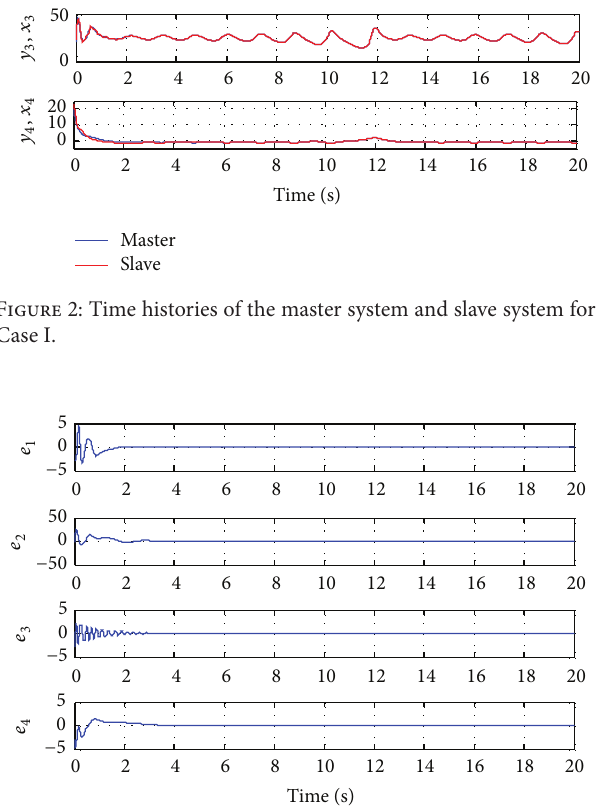
Figure 3: Time histories of error states for Case I.